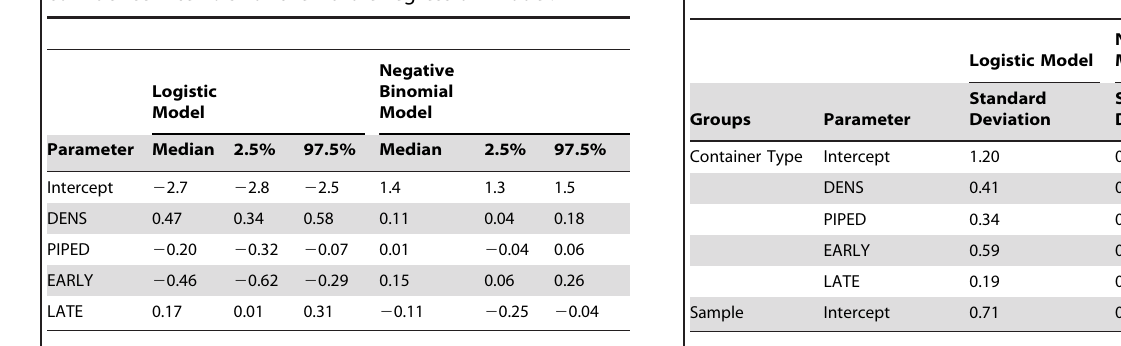
Figure 5. Cross sectional survey Ae.aegypti pupal population prediction. The black dots indicate the number of pupae collected during the repeated early and late season village surveys (2004–2007). The horizontal gray line indicates the median of 1000 simulation values. The thick gray vertical line indicates the central 95% of simulation values, and the thin gray vertical line indicates the range of all the simulations.